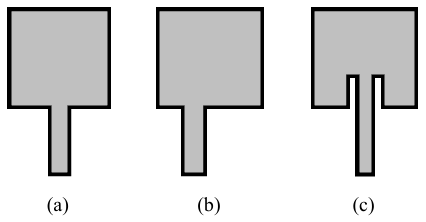
Figure 2. Microstrip feeding techniques. (a) Edge feed. (b) Offset-edge feed. (c) Inset feed.